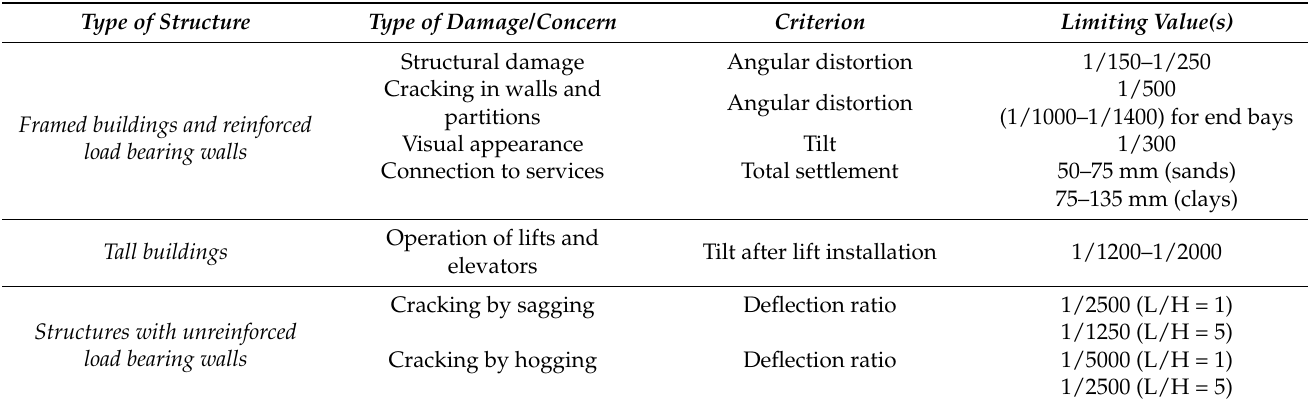
Table 1. Summary of criteria for settlement and differential settlement of structures by sources from the literature, where L = length between panels and H = height (modified after Poulos et al.